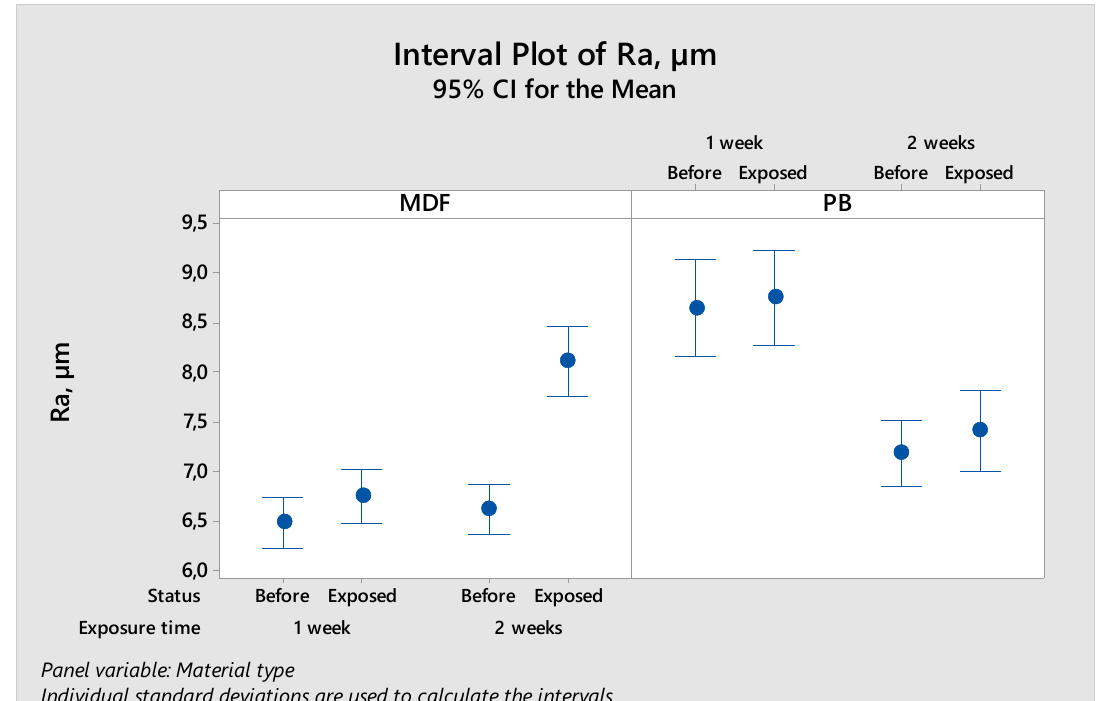
Individual standard deviations are used to calculate the intervals. Figure 3. Variation of the average roughness parameter ( Ra ) of the raw MDF and PB samples, before and after exposure to humidity conditions. Coatings 2019 , 9 , x FOR PEER REVIEW